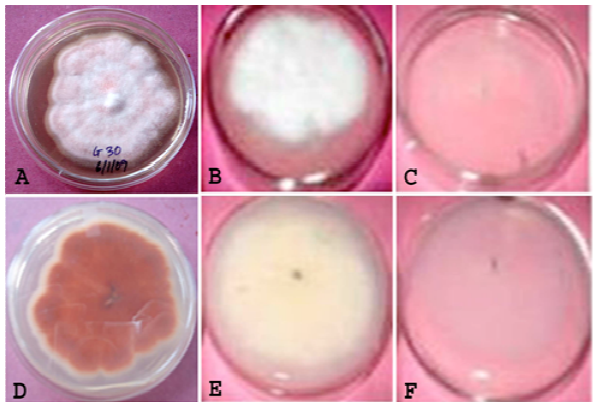
Fig. 2a. A. Fusarium oxysporum G30 on PDA media; B.